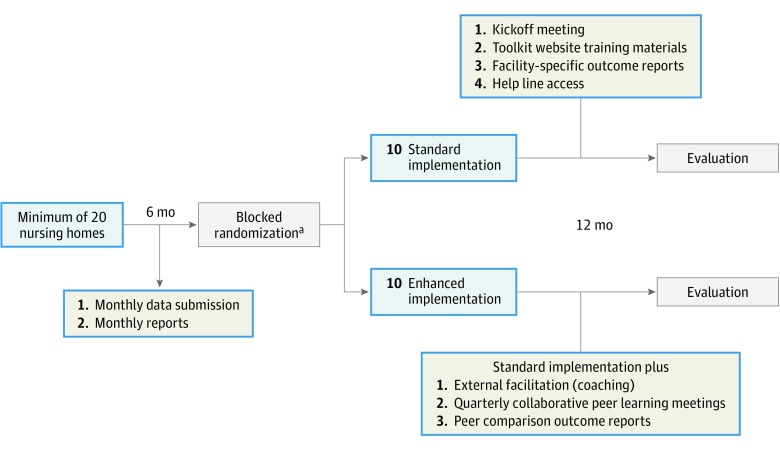
Study OverviewaStratified by rurality in block sizes of 2.